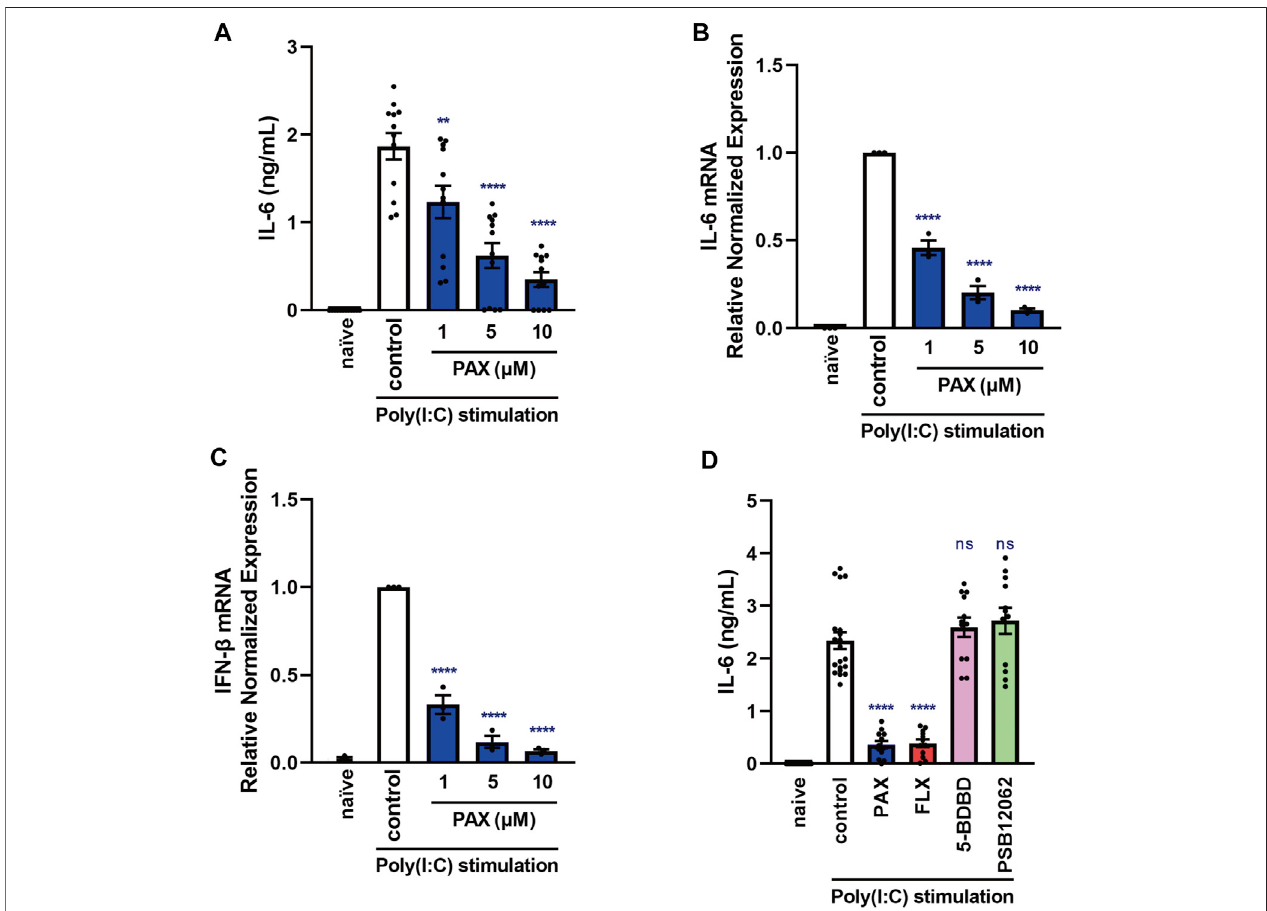
FIGURE 1 | Effects of paroxetine on cytokine production induced by a TLR3 agonist in J774.1 murine macrophage cells. (A – C) J774.1 cells were pre-incubated withparoxetine (1 – 10 µM)for30 minandthenincubated withpoly(I:C)(5 μ g/ml)for3 h (B,C) or6 h (A) . (D) Cellswerepre-incubatedwithparoxetine(10 µM), fl uoxetine (10 µM), 5-BDBD (10 µM) or PSB12062 (10 µM) for 30 min and then incubated with poly(I:C) for 6 h. (A, D) IL-6 was measured by means of ELISA. (B,C) Expression of IL-6orIFN- β mRNAwasanalyzedbyreal-timeRT-PCR. Errorbarsindicate±SE[ (A) : n =12, (B,C) : n =3, (D) : n =12 – 20,threeormoreindependent experiments]. Statistical analysis was performed by one-way ANOVA followed by Dunnett ’ s test. Signi fi cant differences between control and test groups are indicated by ** p < 0.01, **** p < 0.0001. ns, not signi fi cant; PAX, paroxetine; FLX, fl